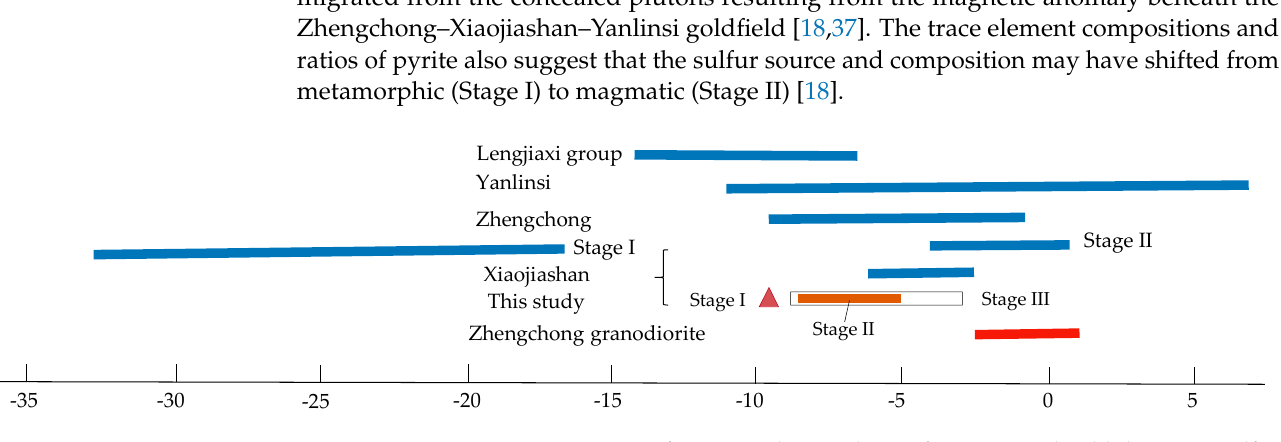
Figure 11. S isotopic compositions of pyrite and granodiorite from regional gold deposits. Sulfur isotope data of the Lengjiaxi Group [13,21,40], Yanlinsi [21,22], Zhengchong [14], Stages I and II [18], Xiaojiashan [28], and Zhengchong granodiorite [14] are shown for comparison. It is thus estimated that the gold in Xiaojiashan was from the Lengjiaxi Formation, and that magmatic materials were added to the